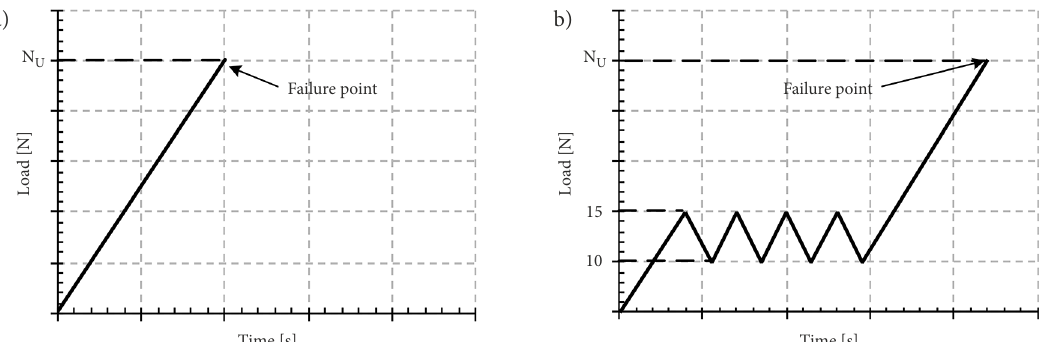
Figure 4. Load character: a – load is increased till failure (1 method); loading in stages (2